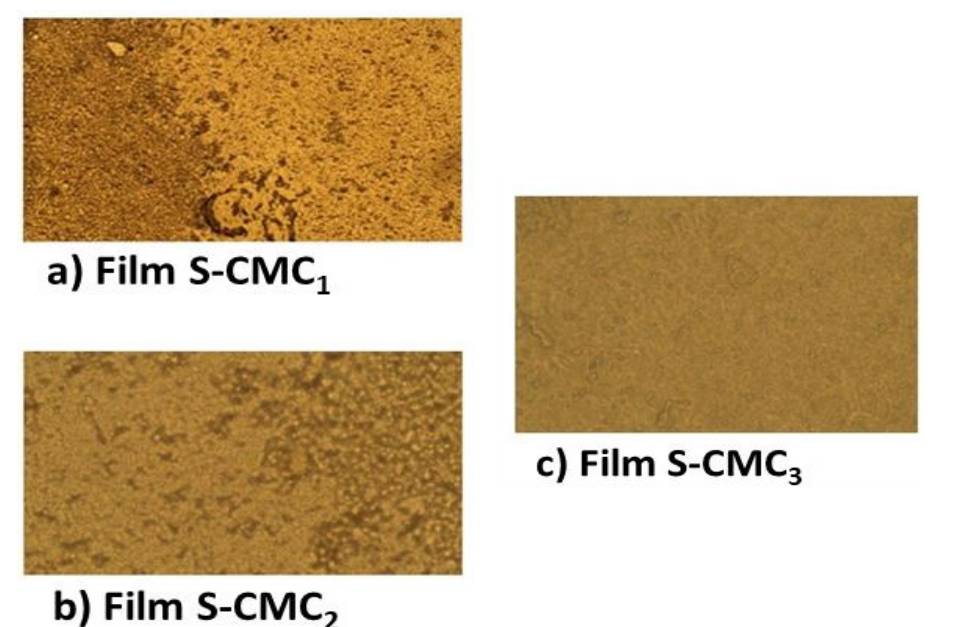
Figure 4. The micrographs show the surface morphology of the three produced films: ( a ) S-CMC 1 ; ( b ) S-CMC 2 ; and ( c ) S-CMC 3 . The images have been collected using a Zeiss microscope in reflection mode using an input objective lens with a magnification of 50 × . Each image shows a 40 × 100 µ m 2 portion of film sample.